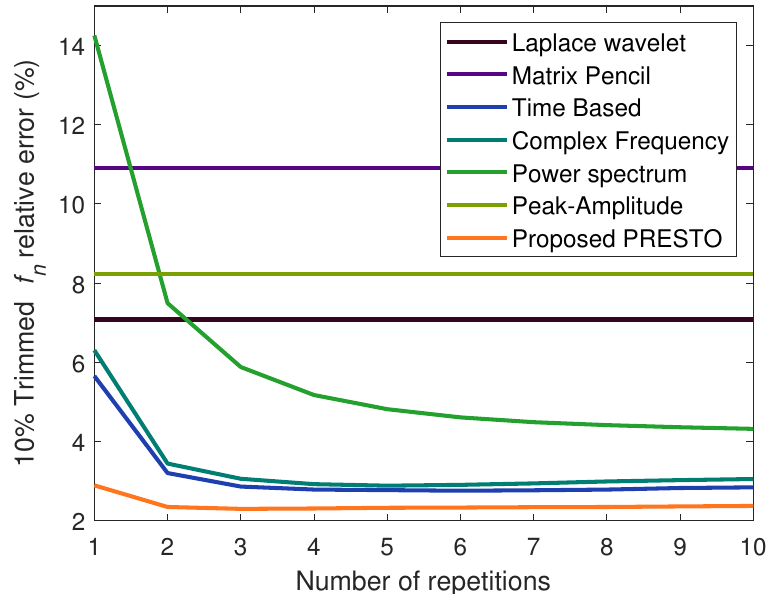
Figure 11. Average relative error (%) in the estimation of the natural frequency ( f n = ω n / ( 2 π ) ) of two simulated underdamped modes excluding the worst 10% cases of the database. SNR 5